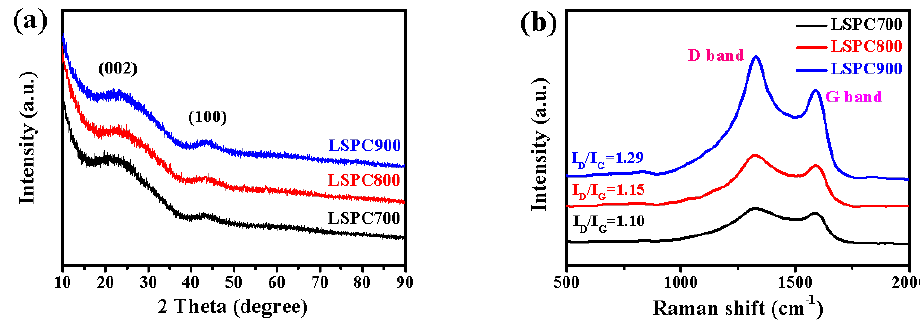
Figure 2. ( a ) X-ray diffraction (XRD) pattern and ( b ) Raman spectra of LSPCs.